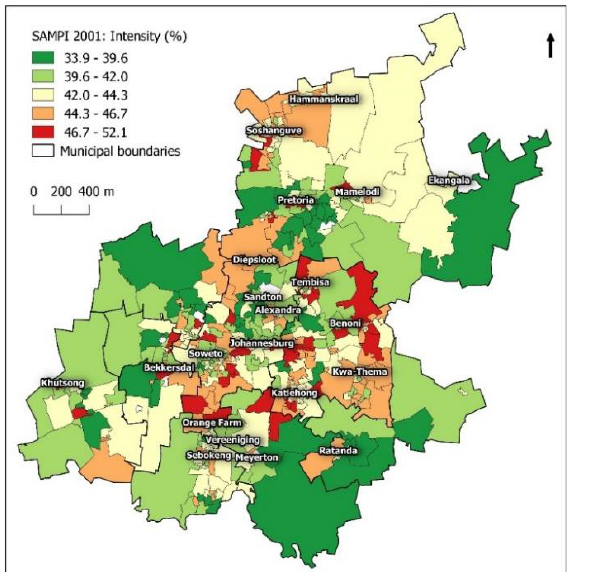
Figure 6. SAMPI in 2001